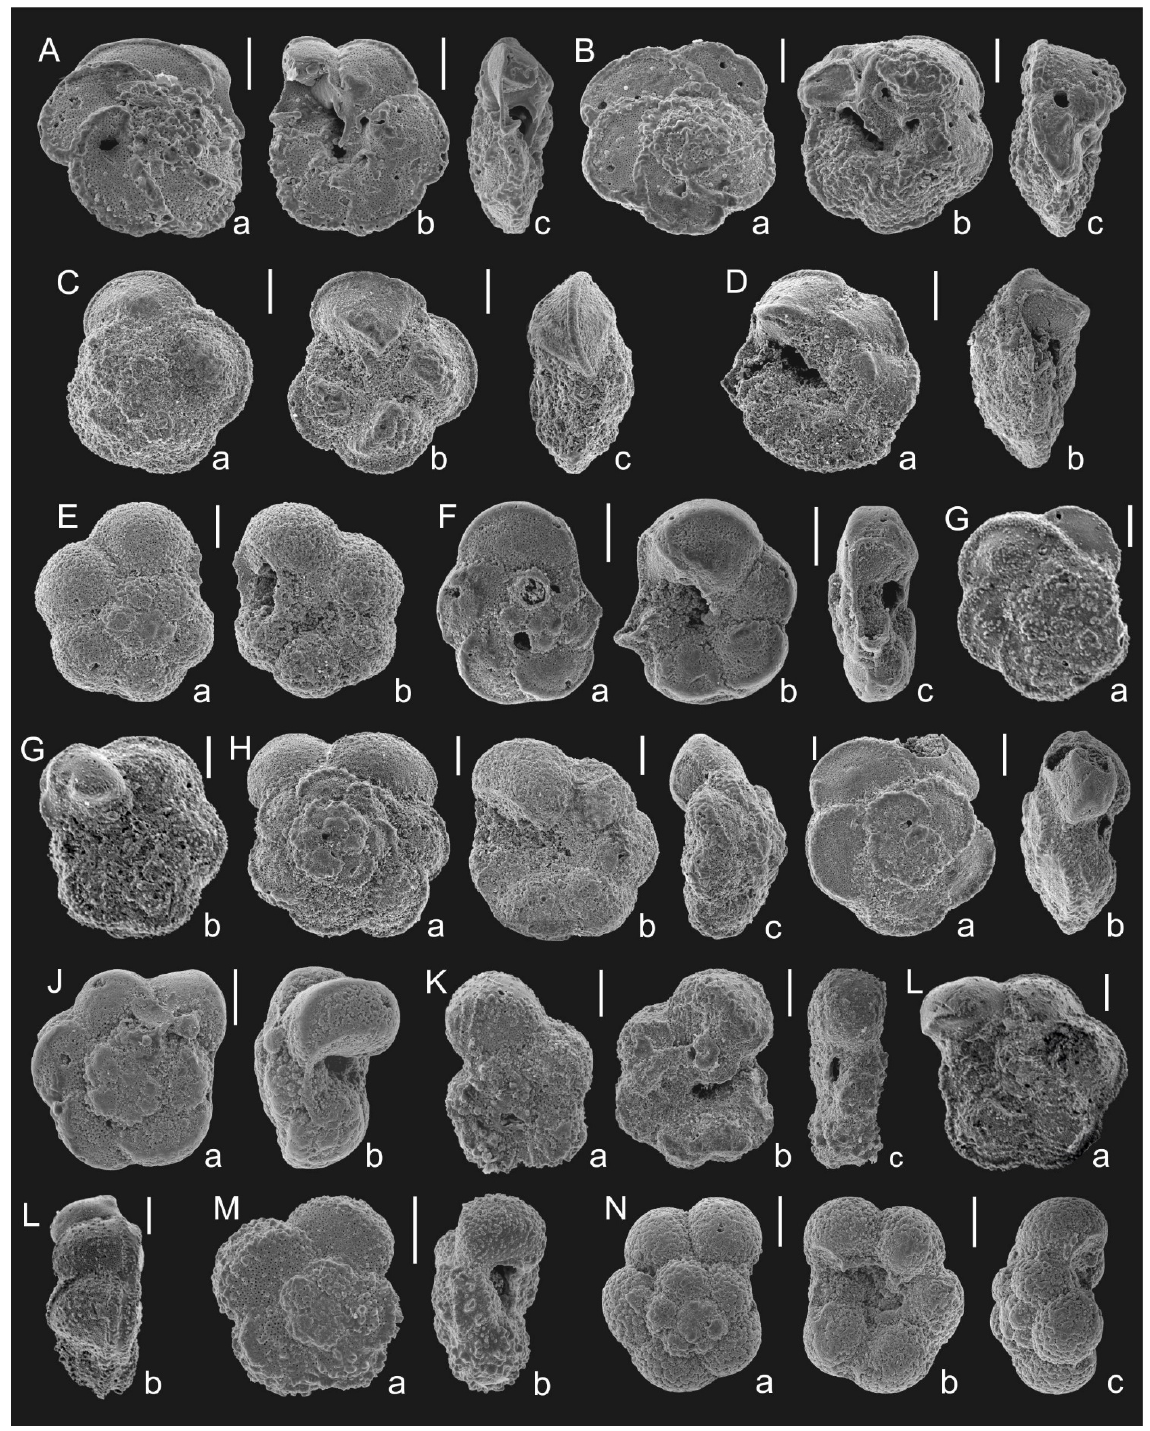
Figure 5. Planktonic foraminifera from the Puławy IG-2 ( A , B ) and S-19 ( C – E , H , I , M ) boreholes, Dubivtsi 1 quarry ( F , J , K , N ) and Słupia Nadbrze˙zna outcrop ( G , L ); A ( a – c ). Thalmanninella globotrun- canoides , depth 855.8 m; B ( a – c ). Thalmanninella reicheli , depth 850.6 m; C ( a – c ). Rotalipora cushmani , depth 460.5 m; D ( a , b ). Thalmanninella greenhornensis ; depth 460.5 m; E ( a , b ). Whiteinella archaeocretacea , depth 458.8 m; F ( a – c ). Dicarinella canaliculata ; G ( a , b ). Dicarinella hagni ; H ( a – c ). Dicarinella imbricata , depth 458.2 m; I ( a , b ). Dicarinella hagni , depth 457.4 m; J ( a , b ). Helvetoglobotuncana helvetica ; K ( a – c ). Falsotruncana sp.; L ( a , b ). Dicarinella concavata ; M ( a , b ). Helvetoglobotuncana helvetica , depth 444.4 m; N ( a – c ). Whiteinella brittonensis . Scale bar = 100 µ